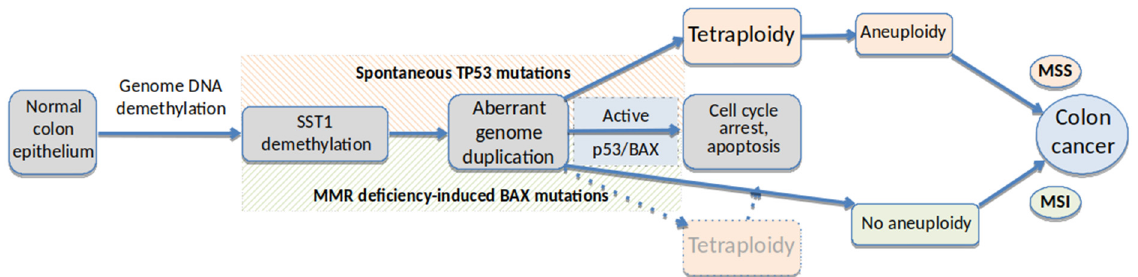
Figure 5. Model for a link between SST1 somatic demethylation, tetraploidy and TP53 and BAX mutations in CRC. In a genomic background of somatic DNA demethylation, strong demethylation of SST1 pericentromeric elements leads to genome duplication and consequent tetraploidy in CRC precursor cells. When cell cycle arrest or apoptosis networks are functional, the resultant tetraploid cells do not proliferate. When TP53 mutations in MSS CRC spontaneously occur before or during the presumably gradual demethylation of these (or other) sequences, the tetraploid cells survive initiating a pathway for aneuploidy and eventually CRC. In a less frequent MSI pathway for CRC, the tetraploid cells can evade apoptosis if there are somatic mutations in BAX and/or other pro-apoptotic proteins. In MSI CRC, the SST1 demethylation-associated tetraploidy is not essential for tumor progression, and the MSI mutator phenotype may lead to a pseudo-diploid